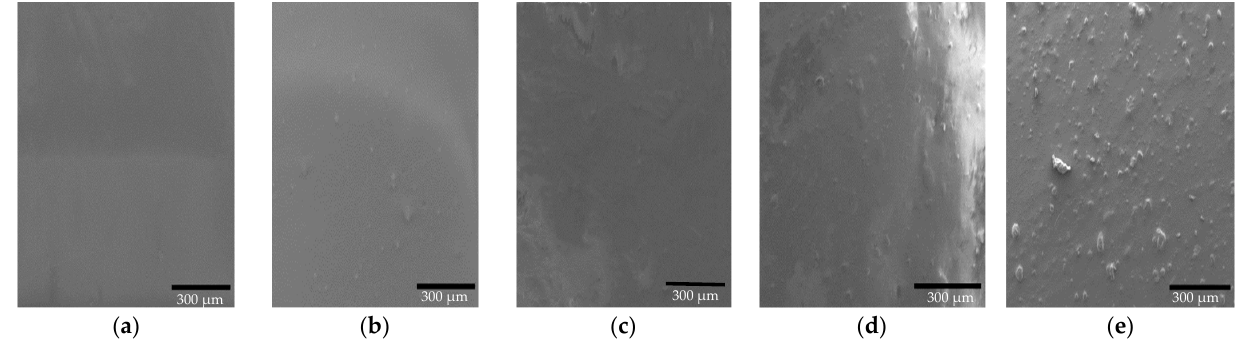
Figure 3. SEM micrographs of ( a ) LDPE/MC-0, ( b ) LDPE/MC-0.5, ( c ) LDPE/MC-1, ( d ) LDPE/MC-3, and ( e ) LDPE/MC-5.